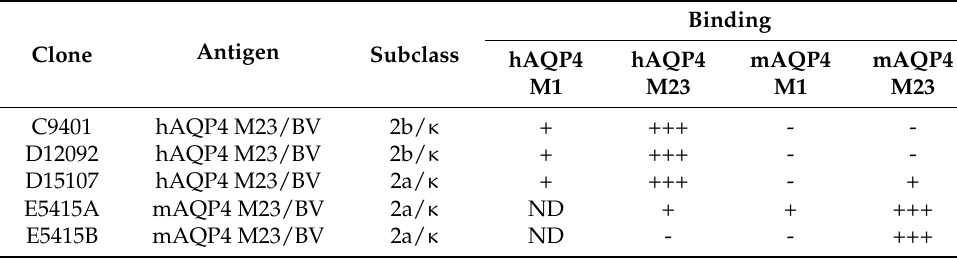
Table 1. Monoclonal antibodies against the extracellular domains of